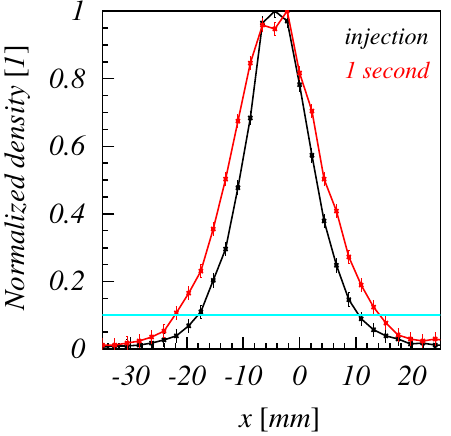
FIG. 15. High intensity bunched beam: (a) Waterfall x beam evolution for Q x ¼ 4 : 3325 , Q y ¼ 3 : 245 . (b) Waterfall x beam evolution for Q x ¼ 4 : 3425 , Q y ¼ 3 : 245 .